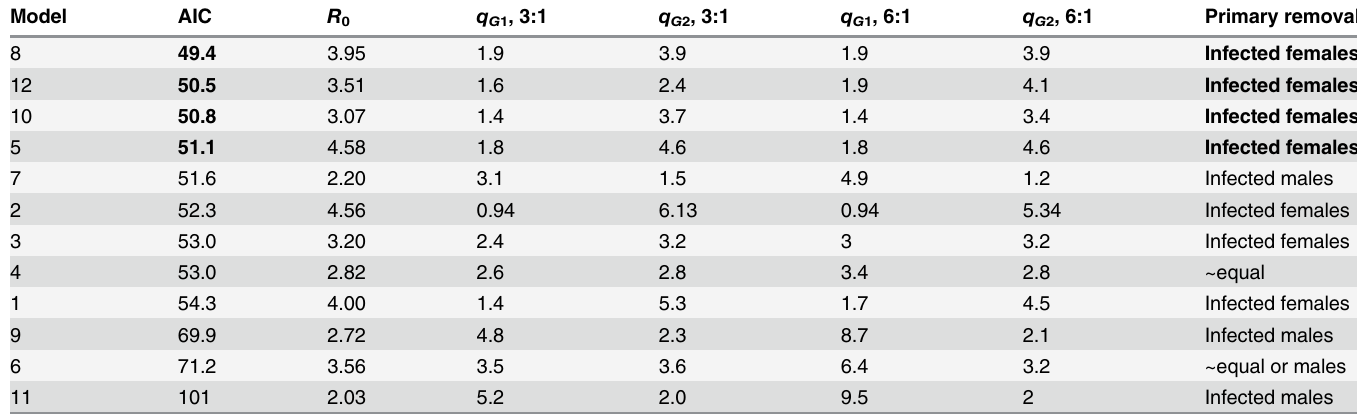
Table 5. The number of new infections in the next generation (10) per one infected male q G 1 and female q G 2 for models in Table 4. Estimates are made for buck:doe ratio of 1:3 and 1:6. In the last column, there is management action giving the biggest reduction of secondary cases per one removed individual.